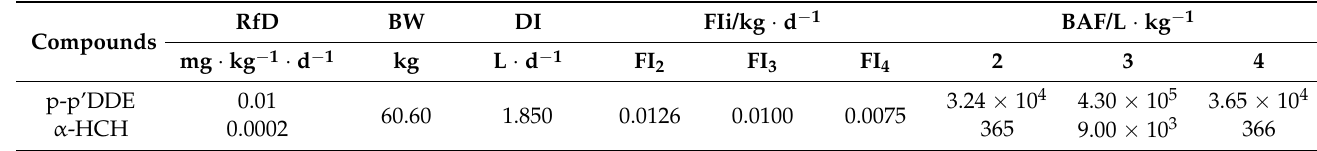
Table 4. Statistical table of human health water quality